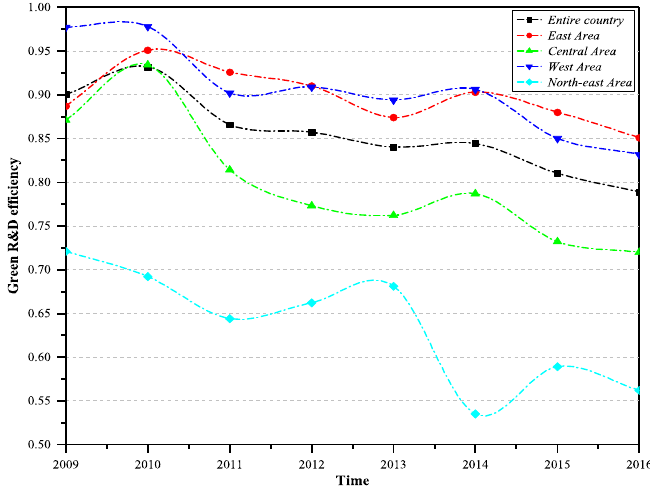
Figure 3. Green technology innovation R&D efficiency of the country and the four major regions (2009 – 2016).